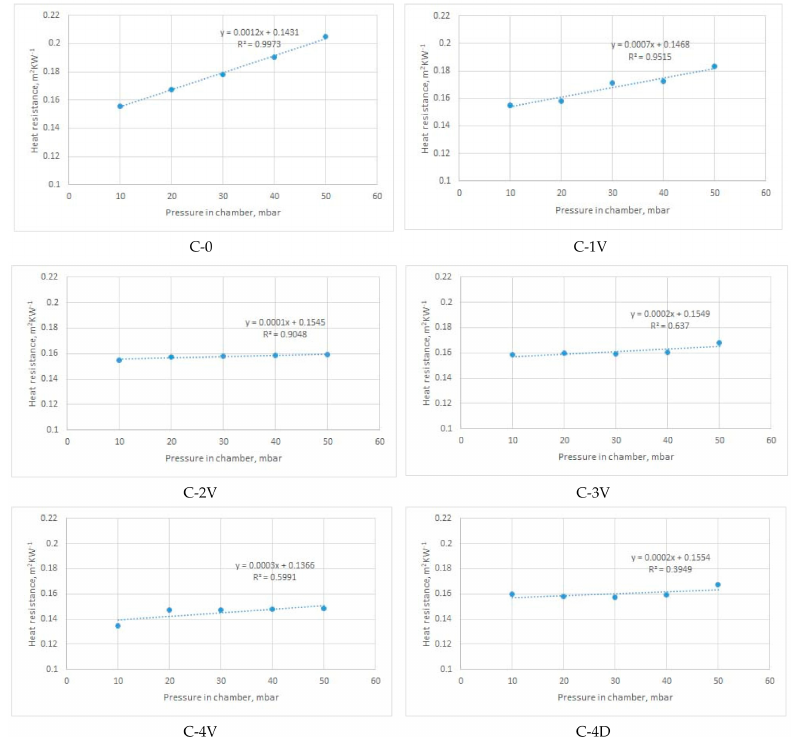
Figure 14. Dependence of heat resistance and air pressure of inflated PICs at a constant ambient temperature of 10 ◦